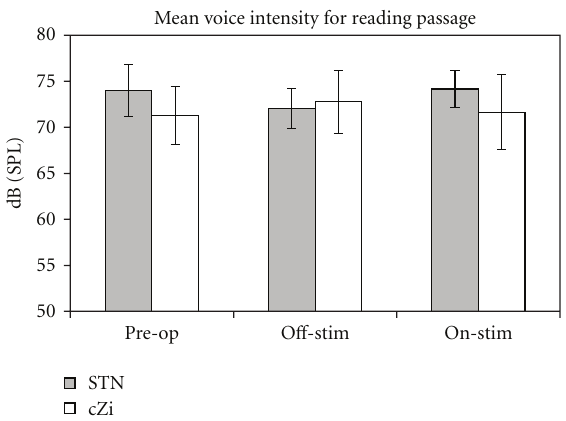
Figure 1: Voice intensity during reading for the STN and cZi groups, respectively, showing means and standard deviations for preoperative and postoperative o ff - and on-stimulation testing